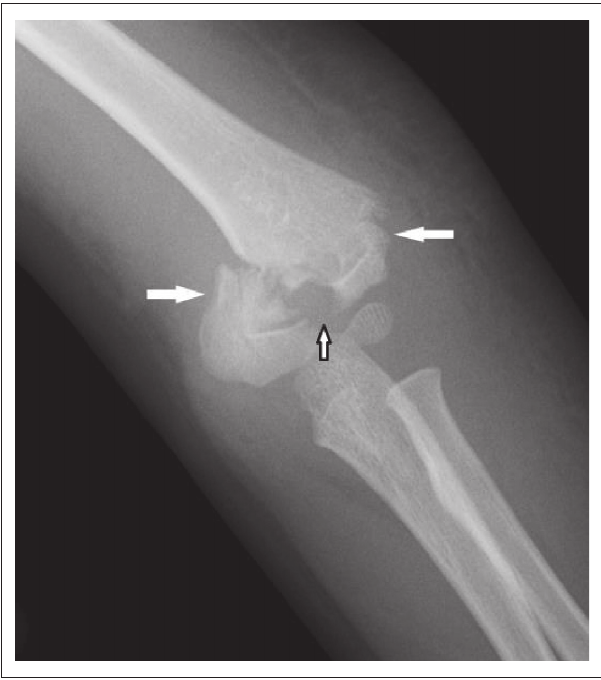
FIGURE 14: Intercondylar fracture that extends sagittally to the articular surface (black and white arrow) splitting the medial and lateral condyles (white arrows).